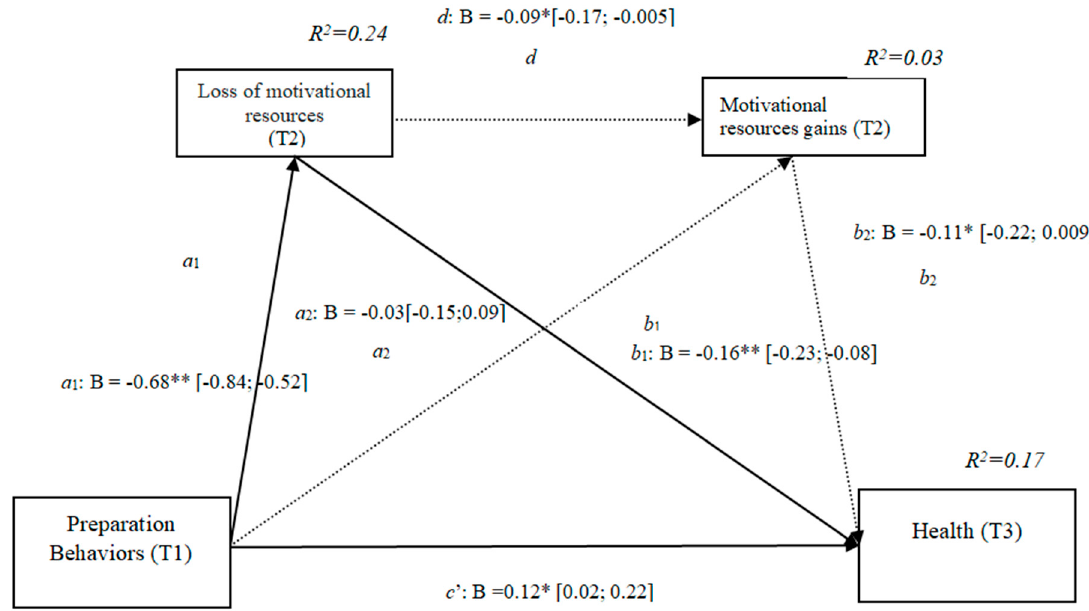
Figure 10. Non-standardized B coefficients, confidence intervals, and statistical significance for motivational losses and gains. [95% CI]; * p < 0.05; ** p < 0.01.